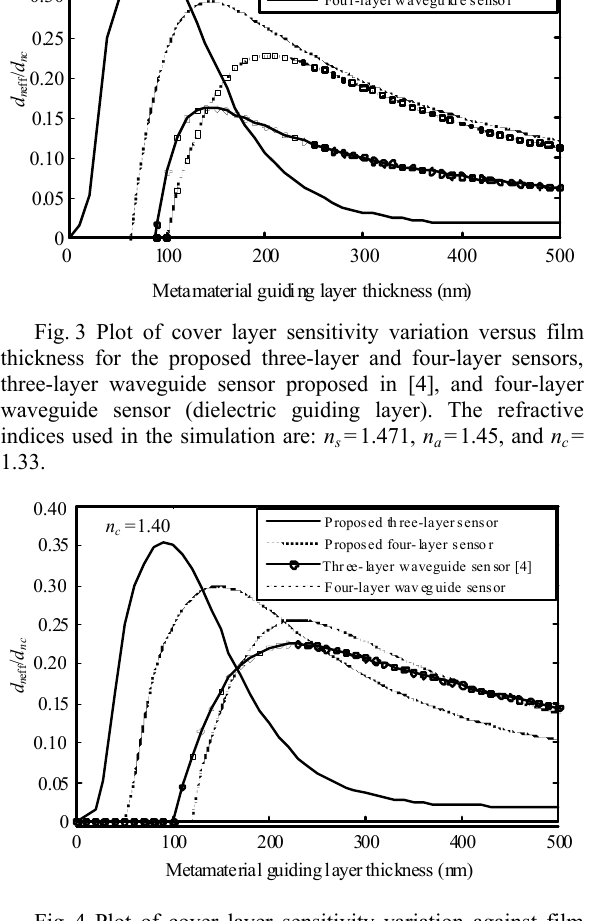
Fig. 4 Plot of cover layer sensitivity variation against film thickness for the proposed three-layer and four-layer sensors, three-layer waveguide sensor proposed in [4], and four-layer waveguide sensor. The refractive indices used in the simulation are: n s = 1.471, n a = 1.45, and n c =